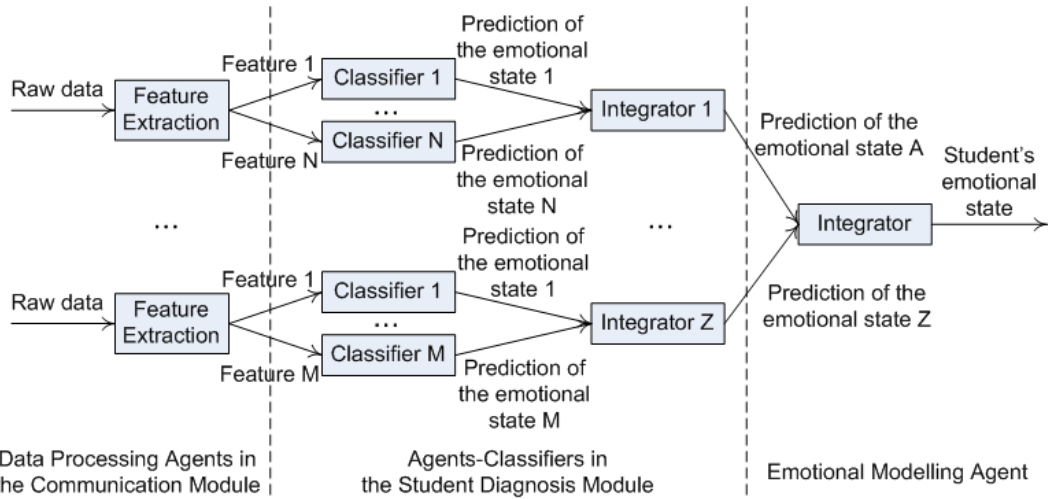
Fig.3. The decision making process concerning the student’s emotional state